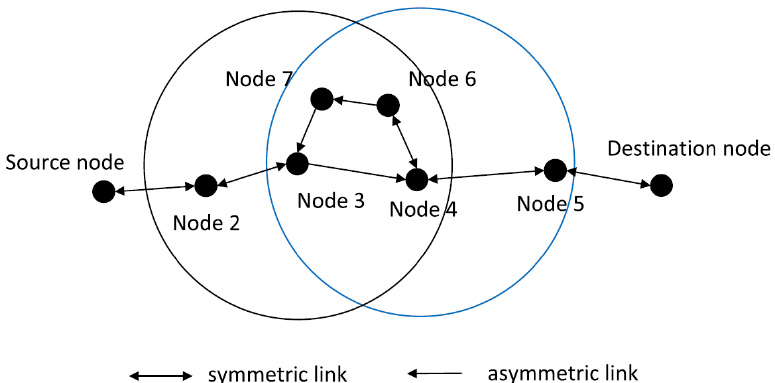
Figure 7. Greedy route establishment phase.